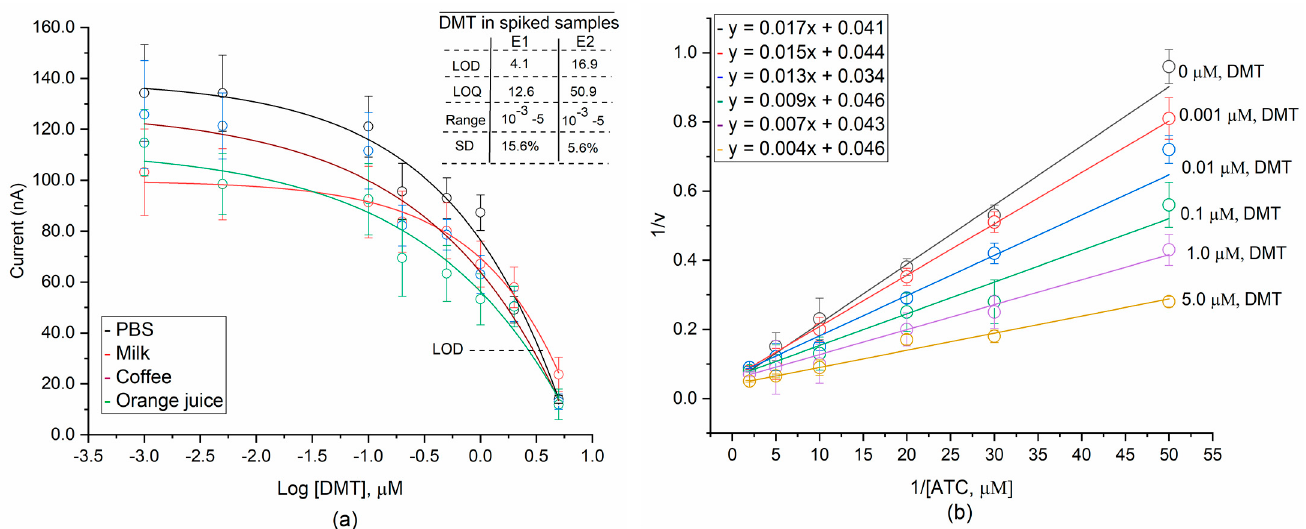
Figure 6. Determination of DMT inhibition patterns. ATC titration of steady-state velocity of AChE in the presence of different concentrations of DMT in PBS, milk, coffee, and orange juice. ( a ) A correlation between generated currents versus DMT concentration (in logarithmic base 10). ( b ) Lineweaver–Burk plot for determination of the inhibition pattern of DMT to AChE in the spiking solution of PBS E1: composited electrode, E2: BSA-coated electrodes. Table 1. Comparative Performances of different biosensors in organophosphate detections.